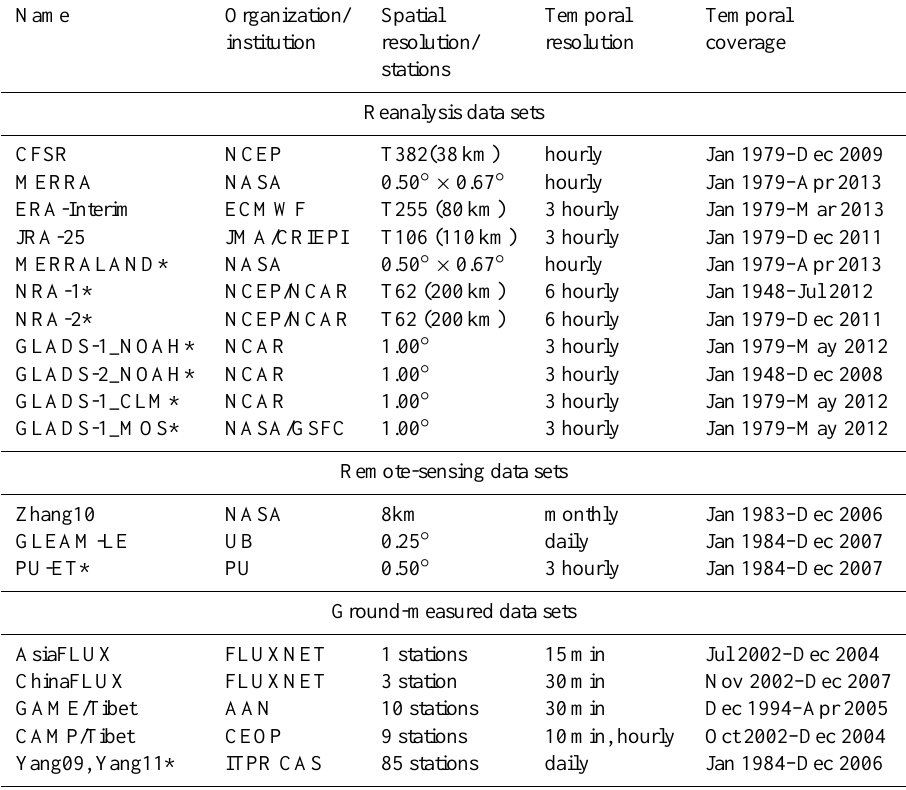
Table 1. Summary of data sources (* for